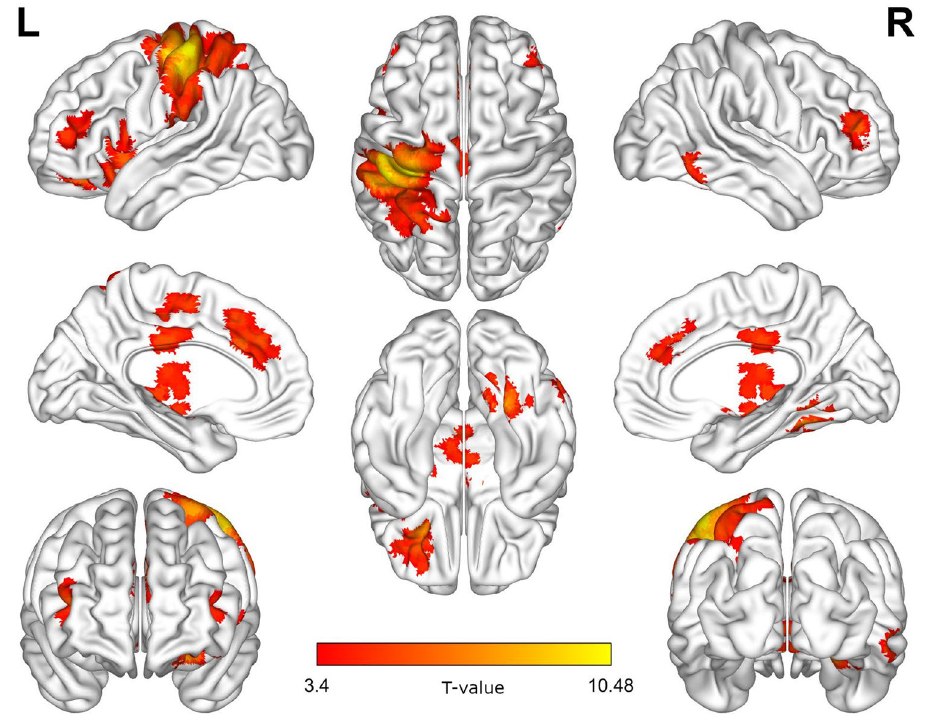
Figure 4. Brain activations (T-map) showing a significant main effect of pain by contrasting conditions: (pain Polish + pain Arab) > (no pain Polish + no pain Arab). Thresholded for voxel-level at p < 0.001 and FWE- corrected p < 0.05 for cluster size.